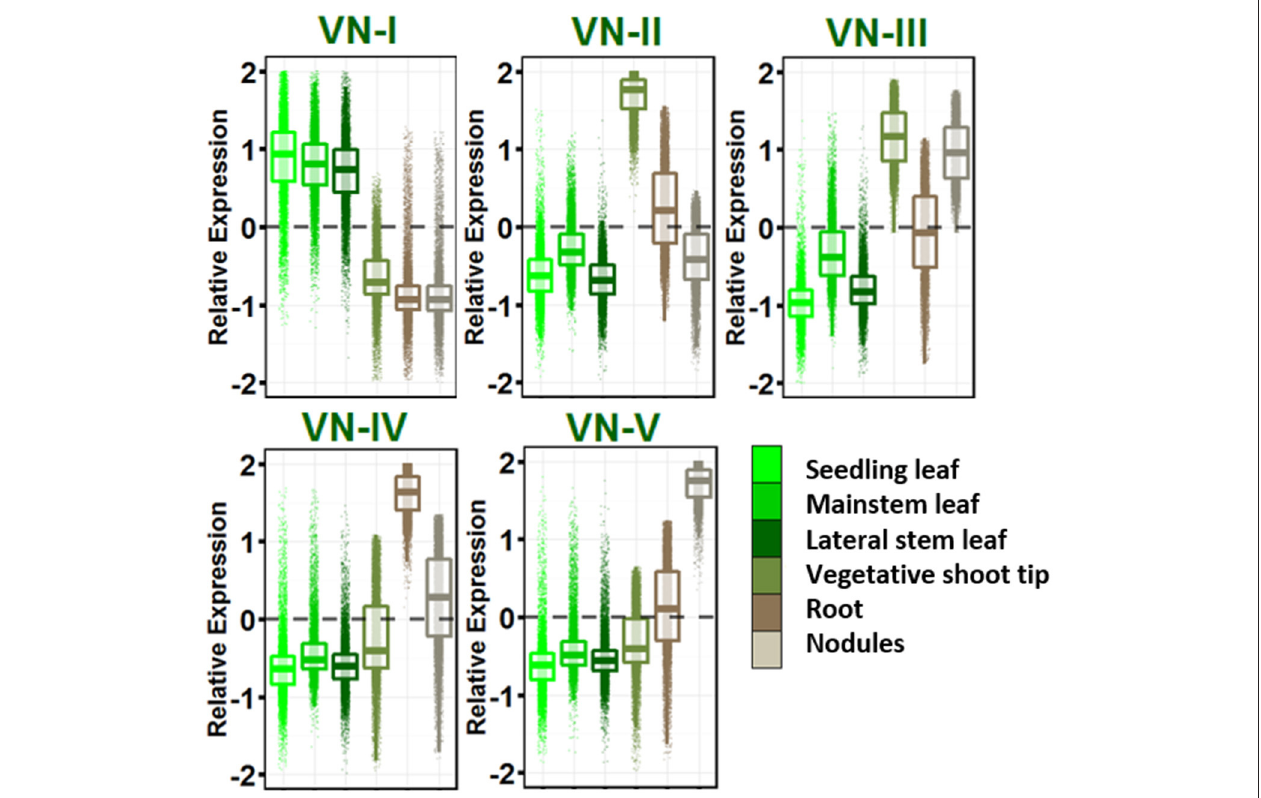
FIGURE 2 | Vegetative gene networks. Relative expression is Z-score transformed FPKM. Plots are jigger boxplots with every gene’s normalized gene expression shown in the plot. Boxplot is traditional boxplot with median, and upper and lower quartiles. Each tissue is colored as in key to right in the same